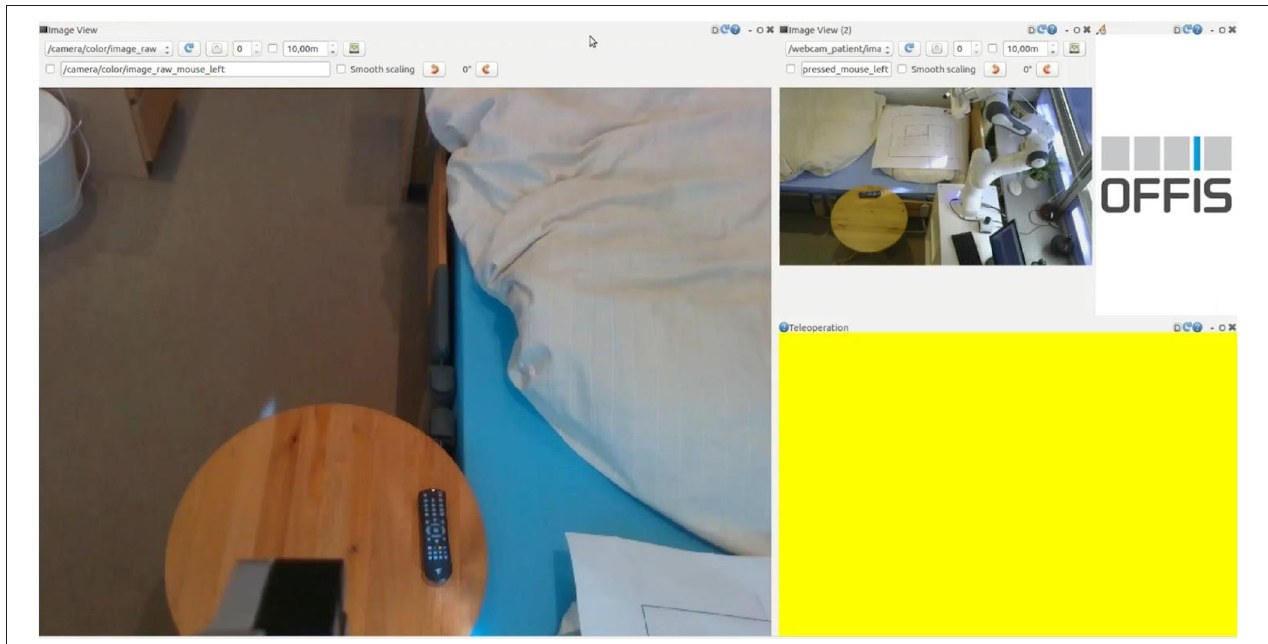
FIGURE 4 | Graphical User Interfaces on the master side. On the left, the video image from the camera at the end effector, from this perspective the manipulator is controlled. On the top right is the video image for the bird’s eye view, this is used for the overview and the recognition of the overall situation. The right-bottom part of the GUI, colored with yellow, indicates the position in the screen where the mouse should be located to control the manipulator. When the mouse is over this area, and the control is enabled, the area turns green.